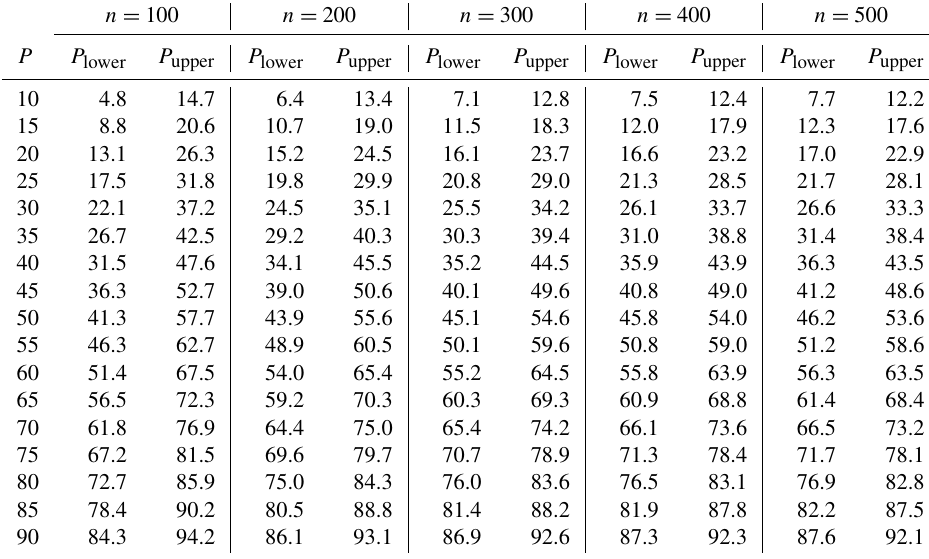
Table B2. Upper and lower percentile confidence interval bounds for α = 0 . 10 (90% confidence